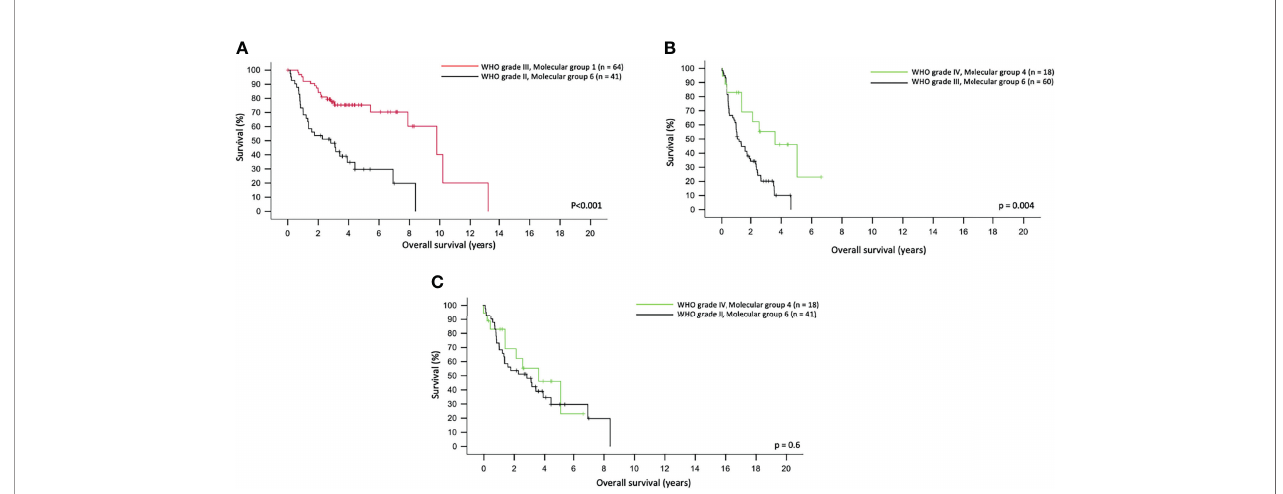
FIGURE 3 | Molecular group superseded the histological grading in predicting overall survival in adult gliomas (A) . WHO grade III, molecular Group 1 tumors had a longer overall survival as compared to WHO grade II, molecular Group 2 tumors. (B) WHO grade III, molecular Group 6 tumors had a signi fi cantly shorter overall survival as compared to WHO grade IV, molecular Group 4 tumors. (C) WHO grade IV, molecular Group 4 and WHO grade II, molecular Group 6 tumors did not differ in overall